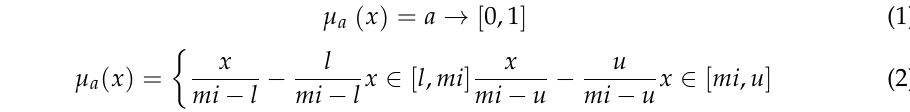
that influence the values using a measure that is highlighted in Table 2.